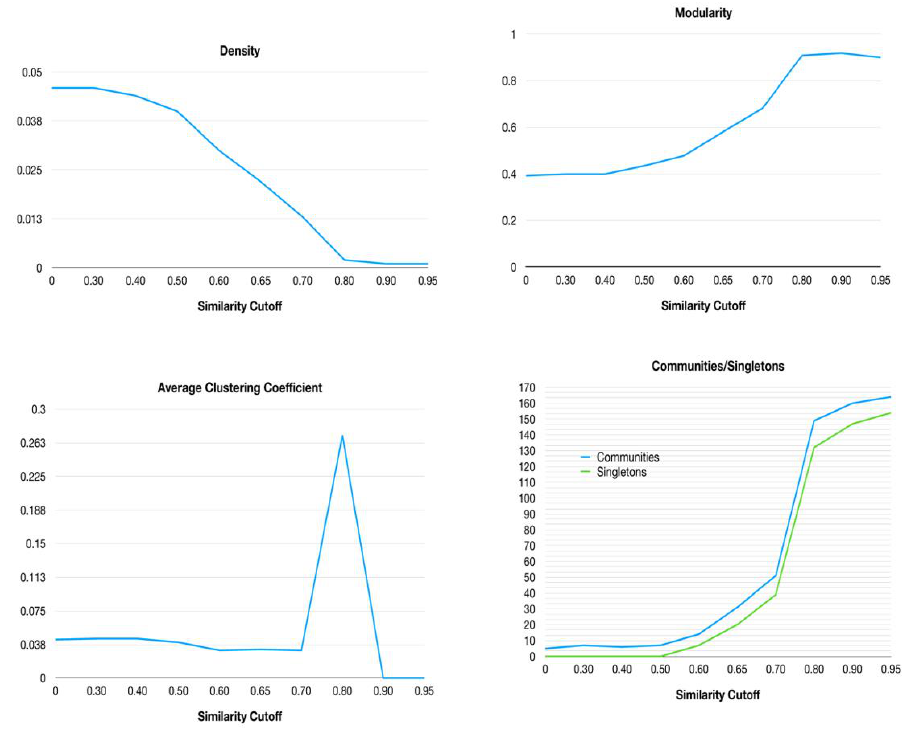
Figure 2. Behavior of HSPNs parameters representing the 174 ABFPs when the similarity cutoff varies from 0 to 0.95. varies from 0 to